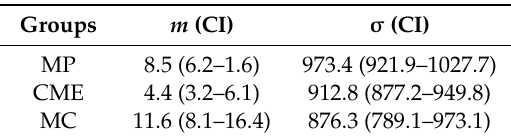
Table 3. Weibull modulus ( m ), characteristic strength (σ), and confidence intervals. The statistical differences were determined based on the confidence interval (CI).